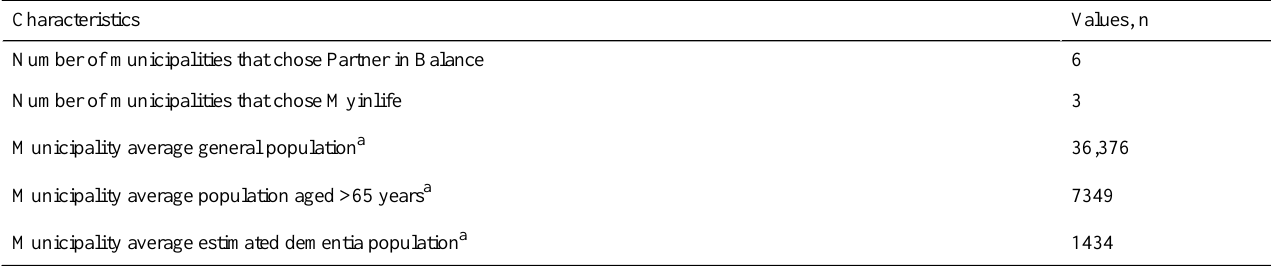
Table 1. Characteristics of the participating municipalities.